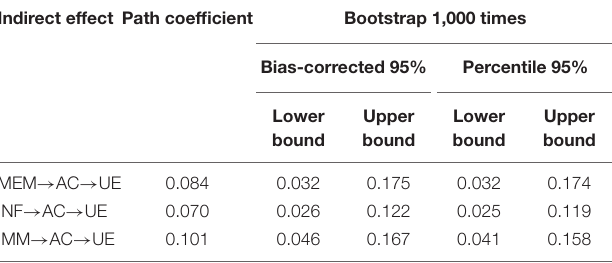
TABLE 7 | The analysis of indirect effect.